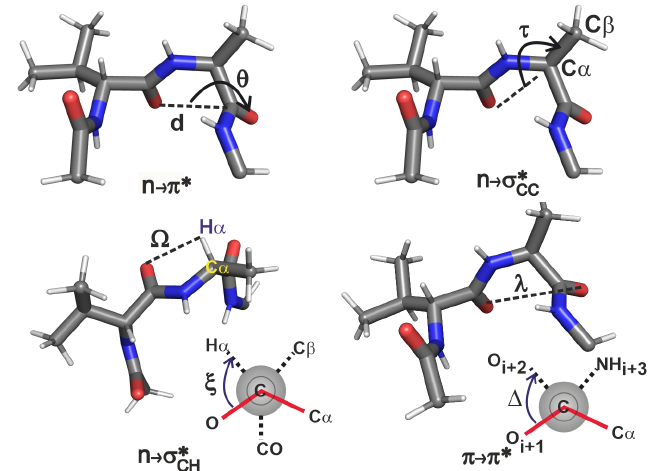
Figure 3. Energies of comparable long-range interactions obtained using NBO deletion analysis. It is seen that upon change in the amino acid (and therefore the side chain) in the i + 2 position, each type of interaction increases or decreases to maintain an overall contribution of ≈ 1 kcal/mol to the lowering of peptide electronic energy.